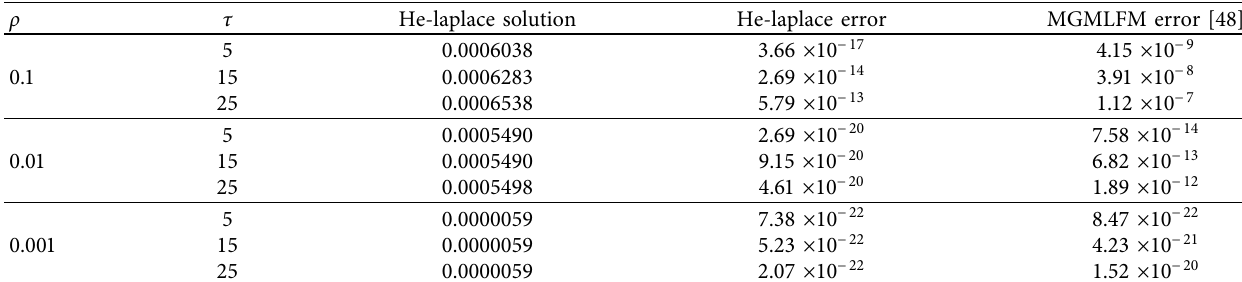
Figure 4: Effect of ] on the solution in Example 1 when α � 0.5, ρ � σ � 1 and x � 7. Table 3: Comparison of He-laplace with MGMLFM in Example 2 when α � 1 and x � 30.